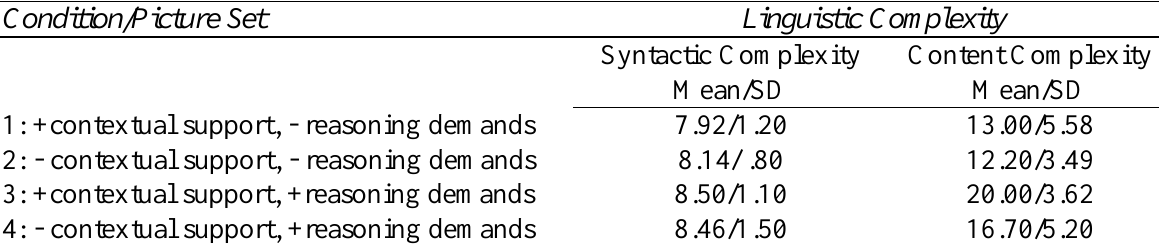
Descriptive Statistics for Experimental Group (n=10)